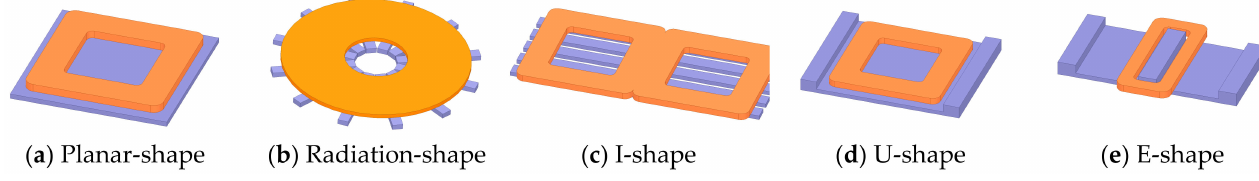
Figure 18. Typical magnetic core shapes of MCR-WPT couplers. Table 12. Applicability and potential shortcomings of shielding methods applied in